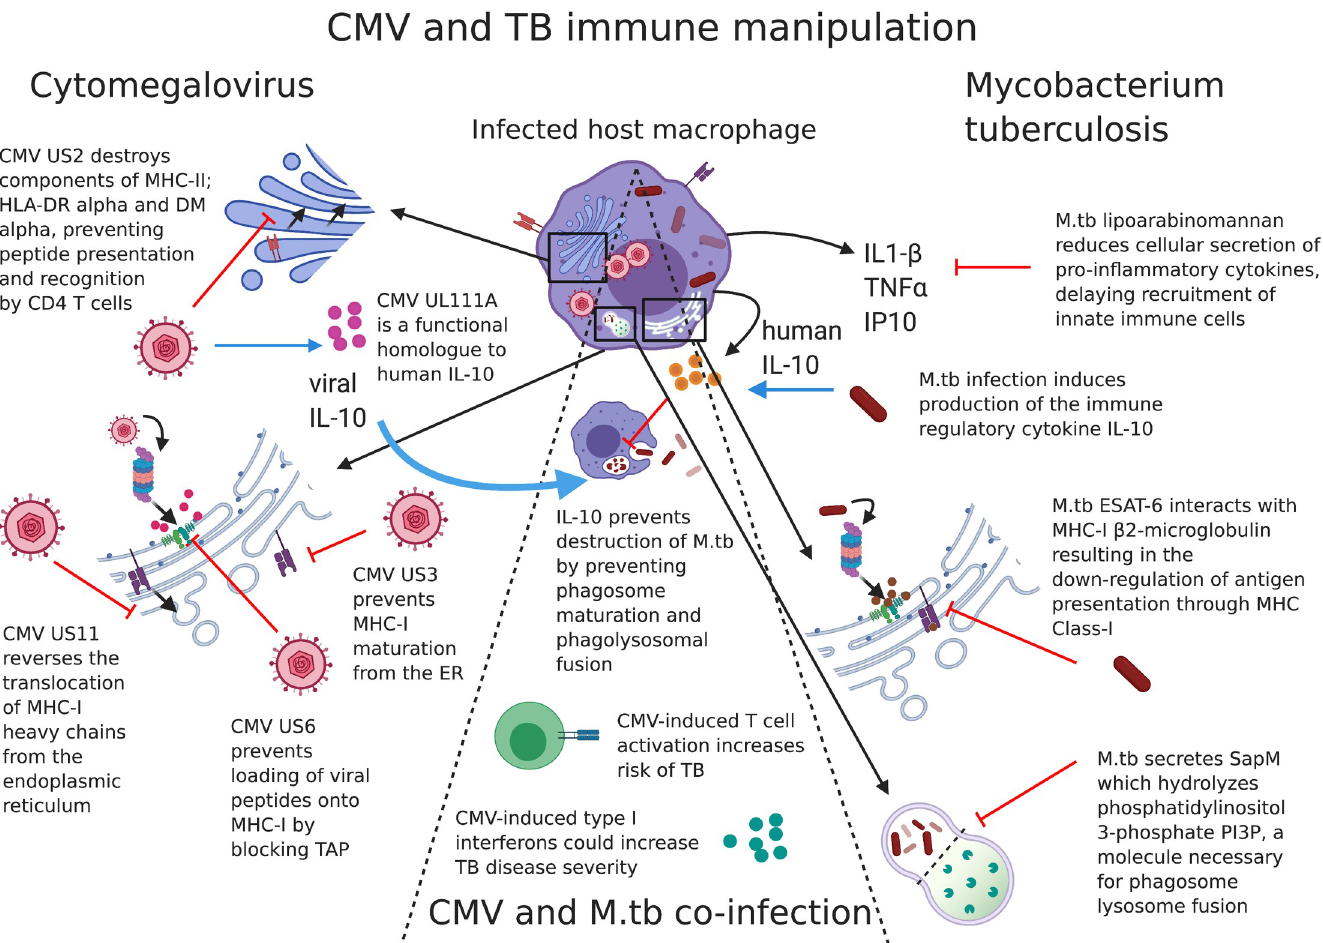
Fig 1. CMV and TB immune mechanisms of host manipulation. Immune manipulation by CMV (left-hand side), Mtb (right-hand side), and some examples of possible interactions between the 2 pathogens (centre) in a host cell. Examples of viral genes expressed during both active replication and latent infection aid CMV in avoiding viral peptides to be displayed on the surface of infected cells. Mtb manipulates cellular machinery to increase or decrease cytokine production and Mtb protein early secreted antigen (ESAT6) down-regulates presentation of mycobacterial peptides via MHC-I. CMV-derived viral IL-10 may interfere with protection against Mtb, and CMV-induced immune activation and enhanced type-I IFNs could increase risk and severity of TB disease. While interactions between CMV and Mtb may occur directly while a host cell is infected with both pathogens, alterations to the wider immunological environment by either pathogen may provide conditions conducive to pathogenesis by the other. The example of immune manipulation mechanisms shown here is not an exhaustive list. C AU : AbbreviationlistshavebeencompiledforthoseusedthroughoutFigs 1 and 2 : Pleaseverifythatallentriesarecorrect : MV, cytomegalovirus; ER, endoplasmic reticulum; IFN, interferon; IL, interleukin; M AU : PleasedefineMHCintheabbreviationlistofFig 1 ifapplicable = appropriate : HC, xxx; Mtb , Mycobacterium tuberculosis ; T AU : PleasedefineTAPintheabbreviationlistofFig 1 ifapplicable = appropriate : AP, xxx; TB, tuberculosis; TNF, tumor necrosis factor.